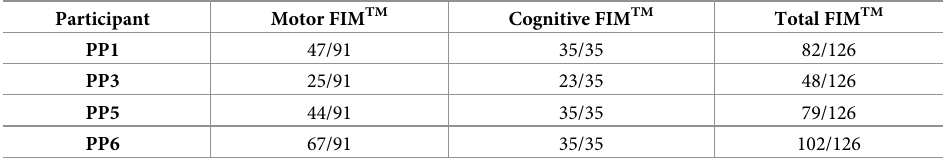
Table 2. FIM TM results of participants who used the system.